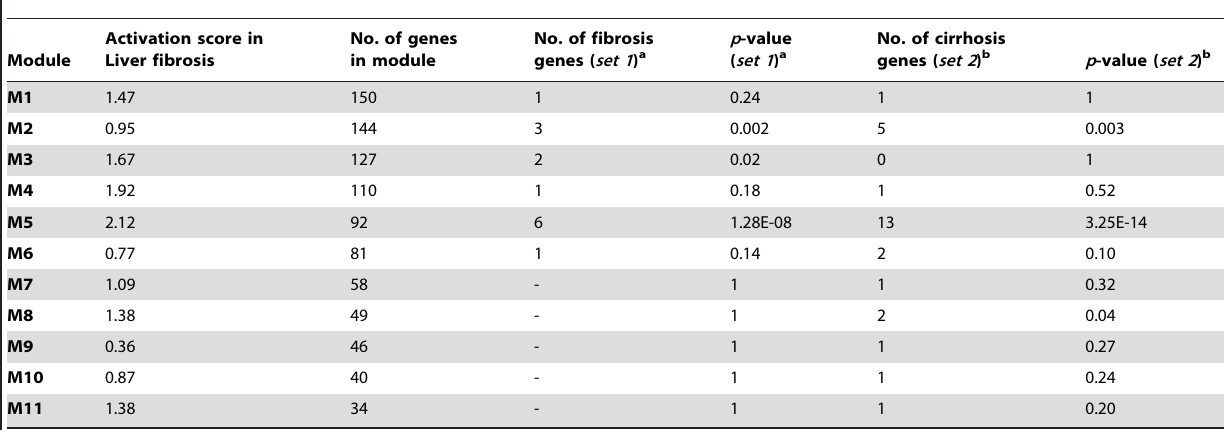
Table 3. Activation of network modules and enrichment of known genes relevant to liver fibrosis.